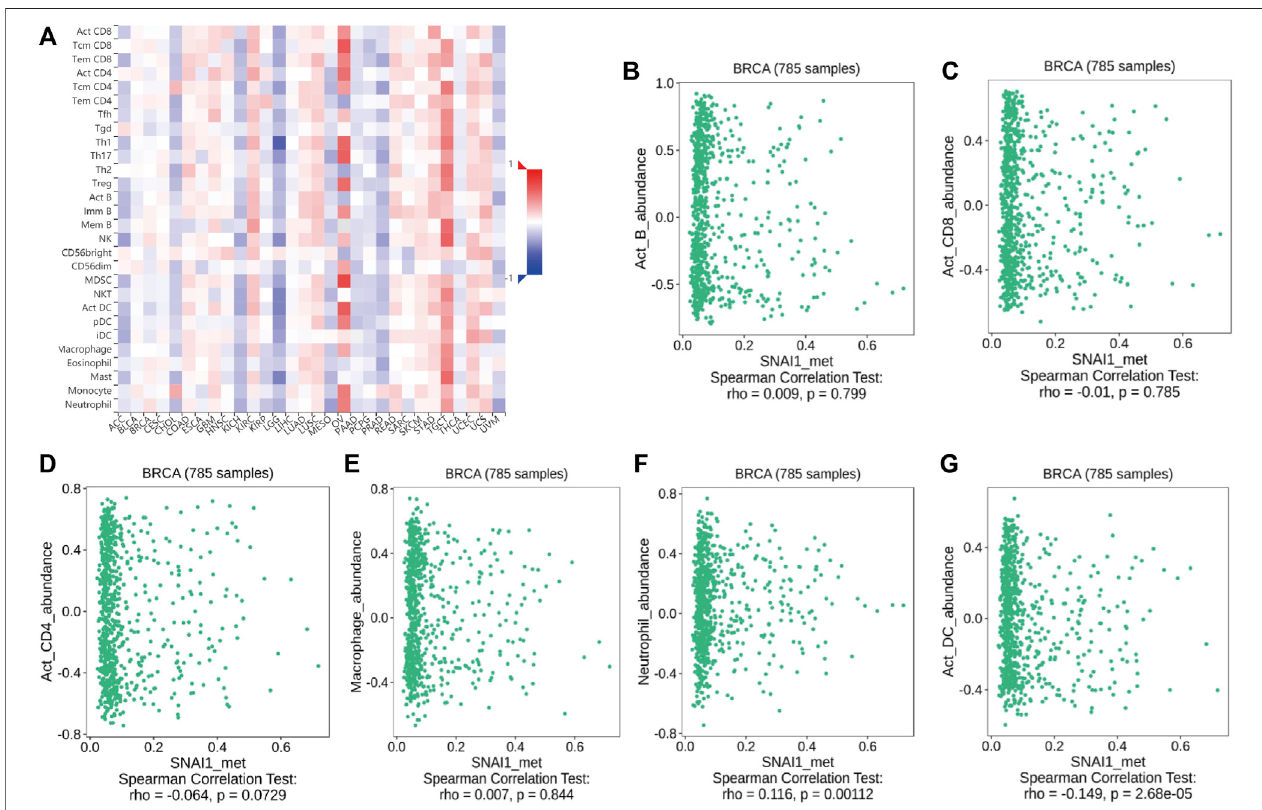
FIGURE 6 | Correlations between SNAI1 methylation levels and immune cell in fi ltration in breast cancer (A) SNAI1 methylation levels in various cancer types and immunecelltypesareshowninheatmaps.Correlationsbetweenchangesinthe SNAI1 methylationlevelandthein fi ltrationof (B) Bcells (C) CD8 + Tcells (D) CD4 + Tcells (E) macrophages (F) neutrophils, and (G) dendritic cells in breast cancer are